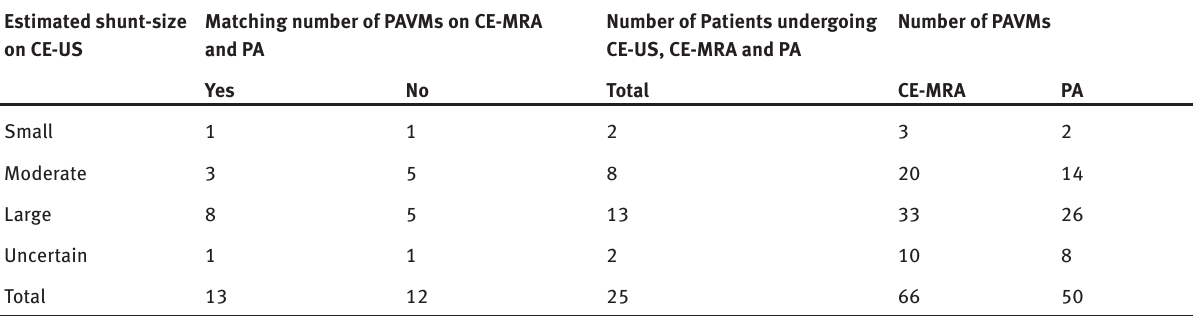
Table 1: Comparison of estimated PAVM-size on CE-US with PAVM-number on CE-MRA and PA Estimated shunt-size on CE-US